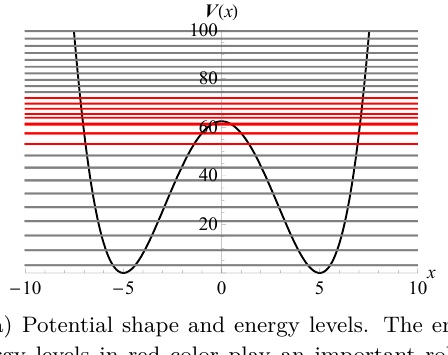
√ 5 , g = 1 / 10 , ( V (0) = 62 . 5)